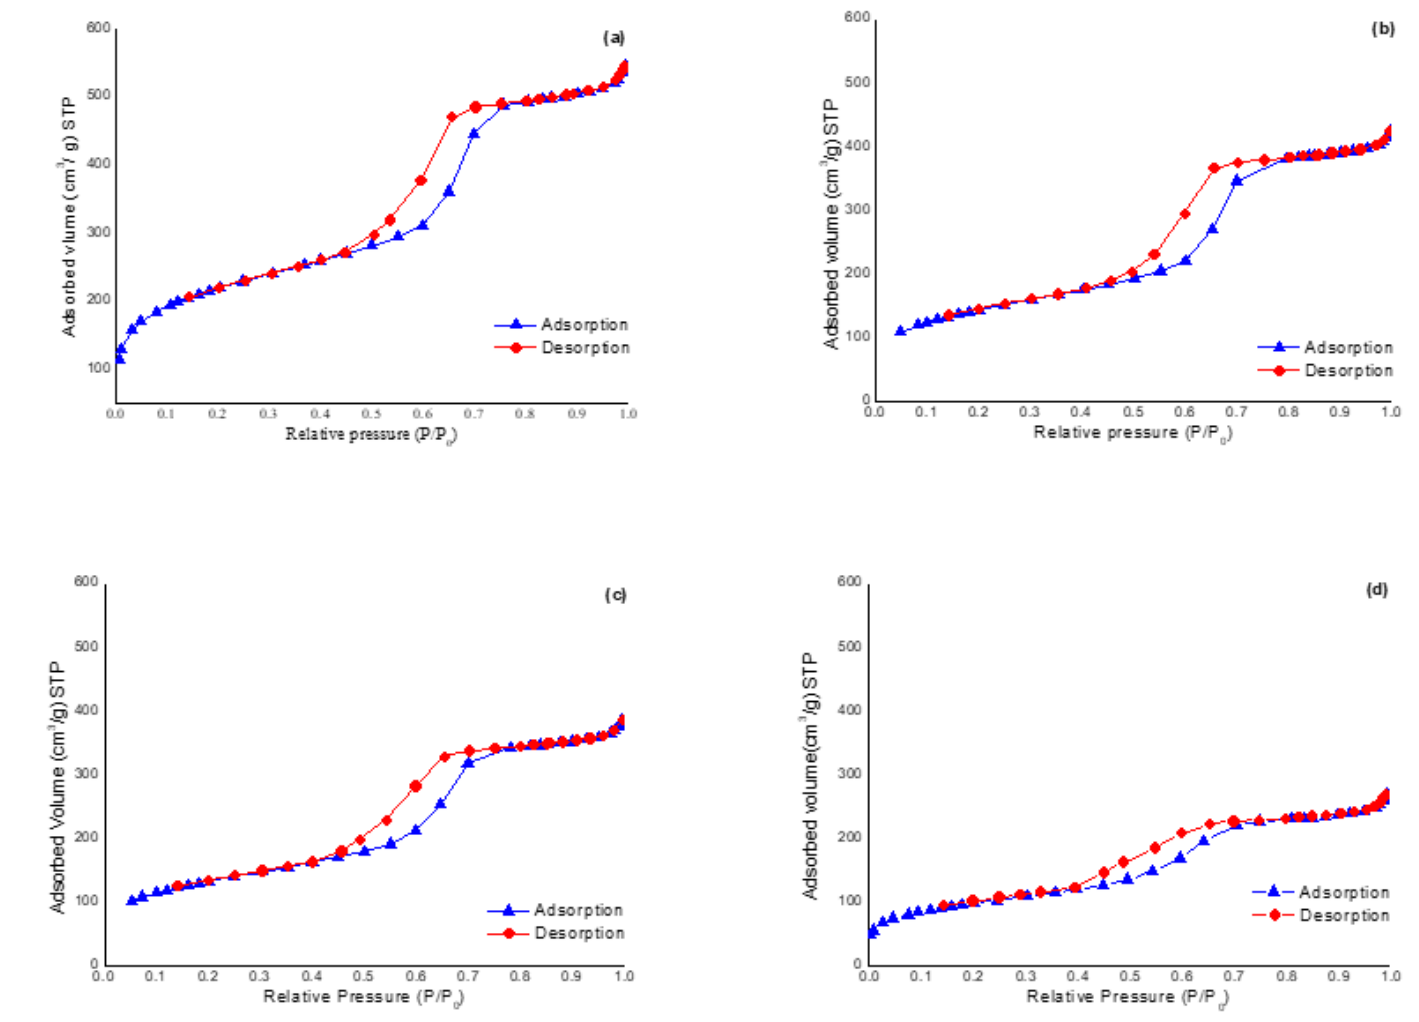
− and ( d ) H-SBA-15-SO − − , ( c ) M-SBA-15-SO 3 3